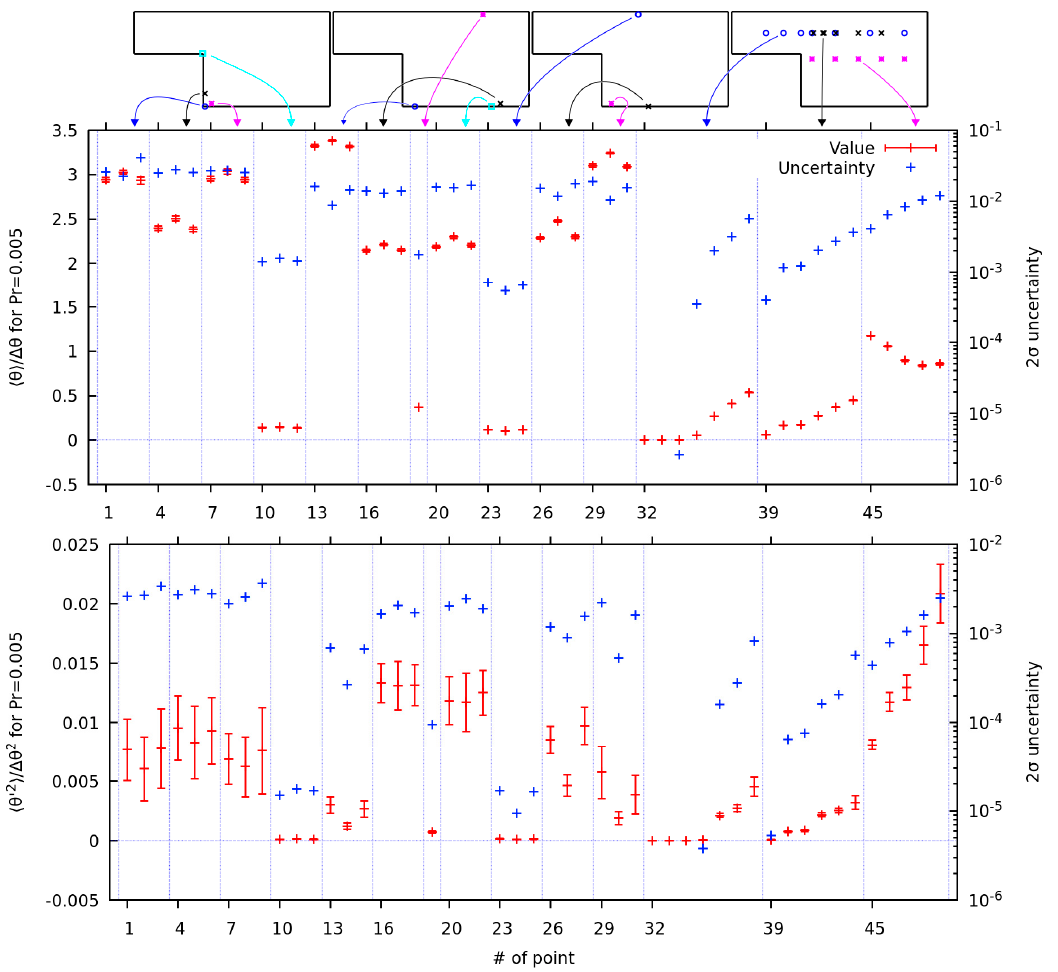
(cid:10) (cid:11) θ (cid:48) 2 / ∆ θ 2 for